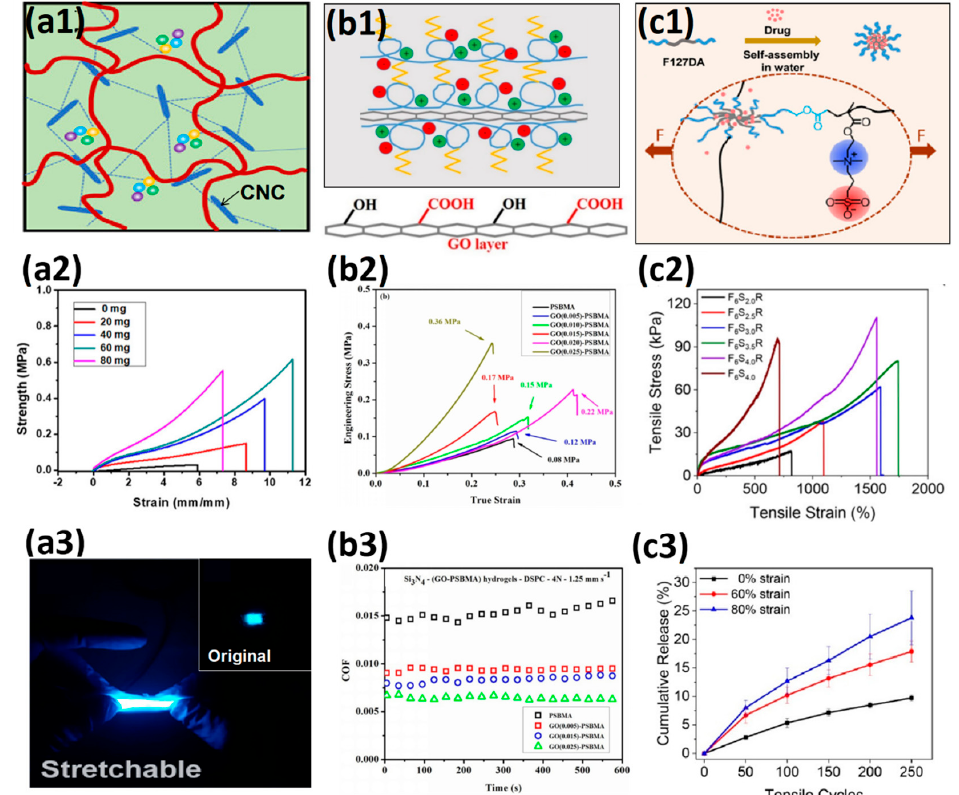
Figure 6. Mechanical strengthening of zwitterionic hydrogels prepared with the functional cross- linker: ( a1 – a3 ) zwitterionic hydrogel with 1D CNC nanotubes ( a1 ) showed enhanced tensile strain and toughness of zwitterionic hydrogels ( a2 ) and further acted as an electroluminescent display ( a3 ). Reproduced with permission from [107]. Copyright 2019, American Chemical Society; ( b1 – b3 ) zwitterionic hydrogels with 2D graphene oxide nanosheets ( b1 ) showed almost 5 times